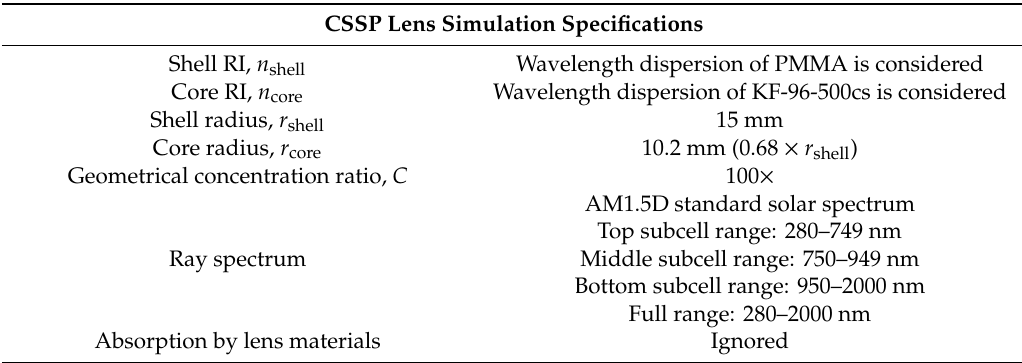
Figure 10. Estimated wavelength dispersion of RI based on the measured RI at four wavelengths and the measured spectral transmittance of KF-96-500cs. Table 4. Simulation conditions B.